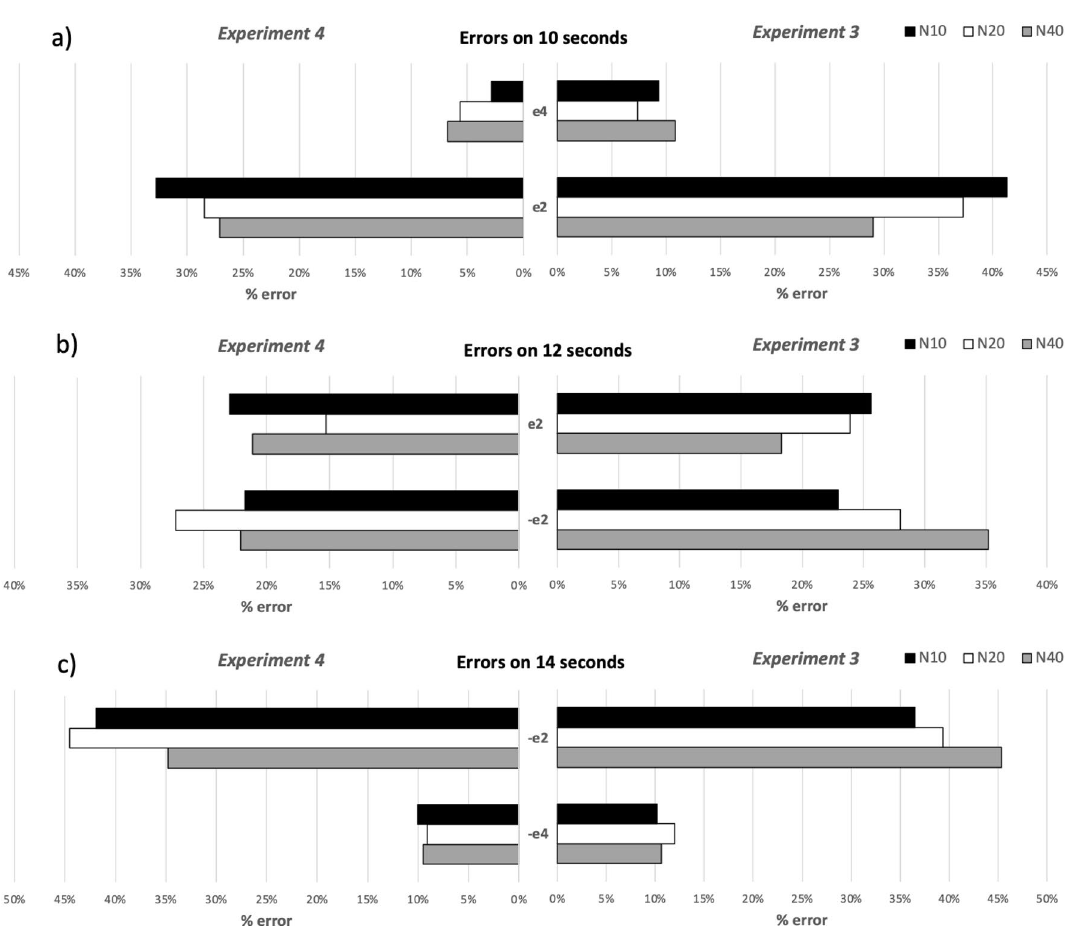
Figure 5. Clustered bars showing error rates at 10-s (upper panels), 12 s (middle panel) and 14 s (upper panel) per steps ( N10 , N20 , and N40 ) and error type (− e2/4: underestimation of 2 or 4 s, e2/4: overestimation of 2 or 4 s)—experiments 3 and